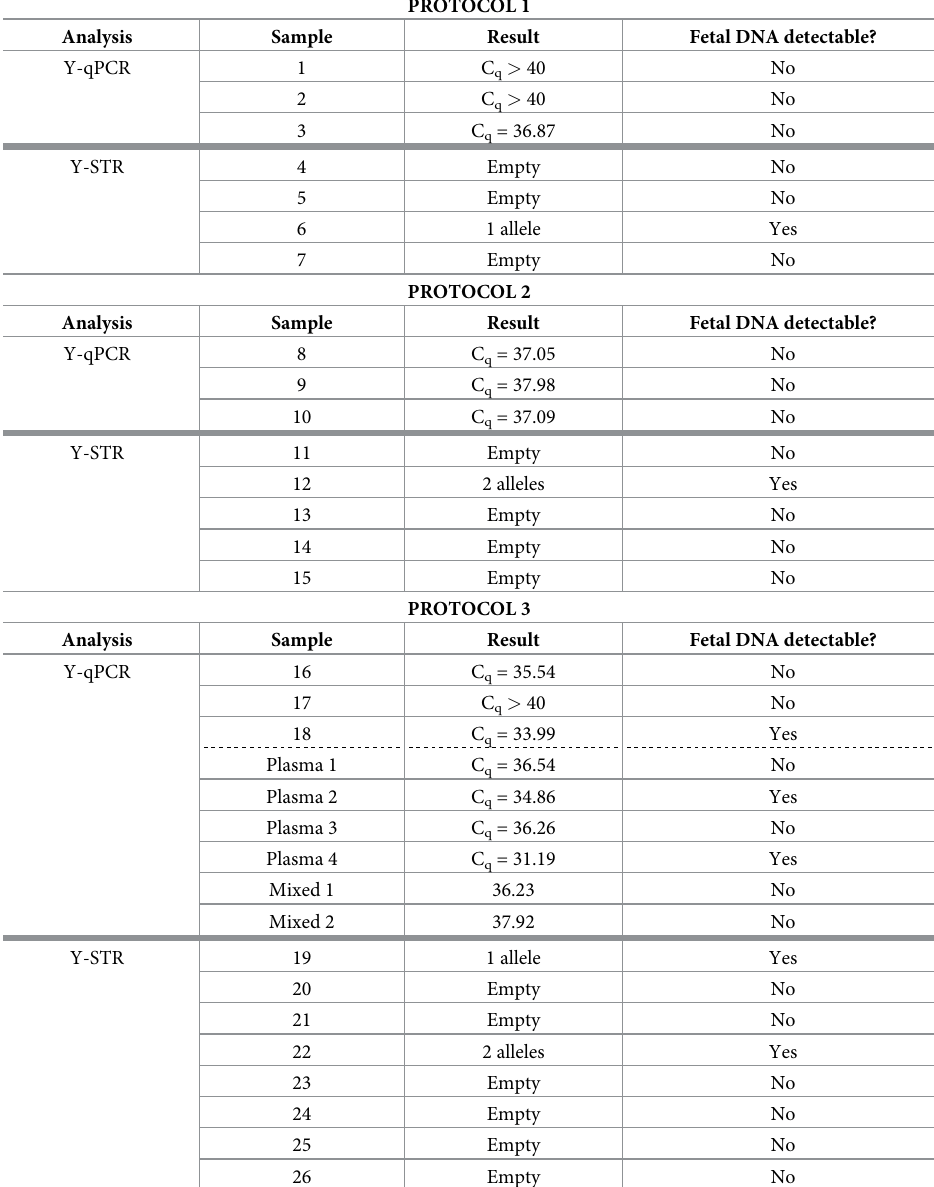
Table 2. Overview of the Y-qPCR and Y-STR results for male fetus samples, male plasma samples, and mixed samples, categorized by protocol and analysis method. PROTOCOL